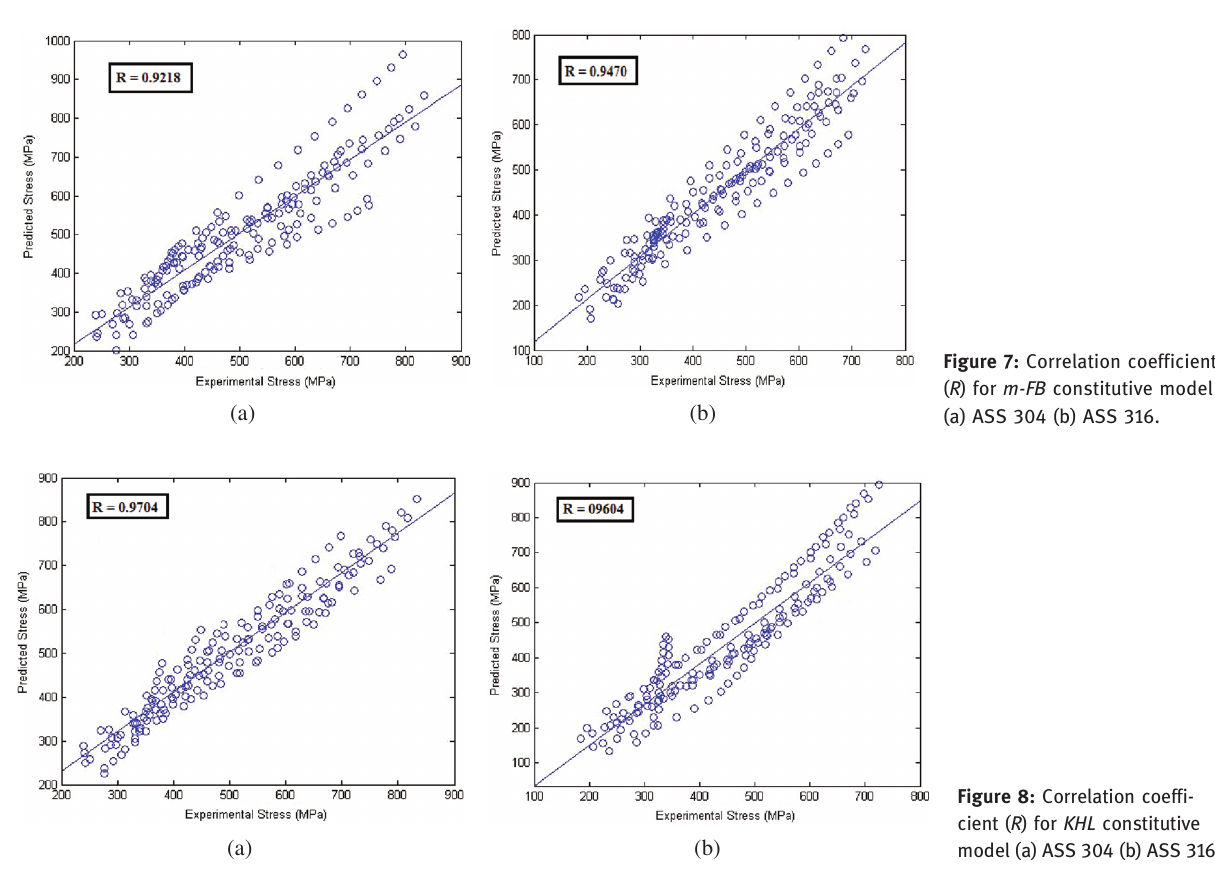
Figure 7: Correlation coefficient ( R ) for m-FB constitutive model (a) ASS 304 (b) ASS 316.